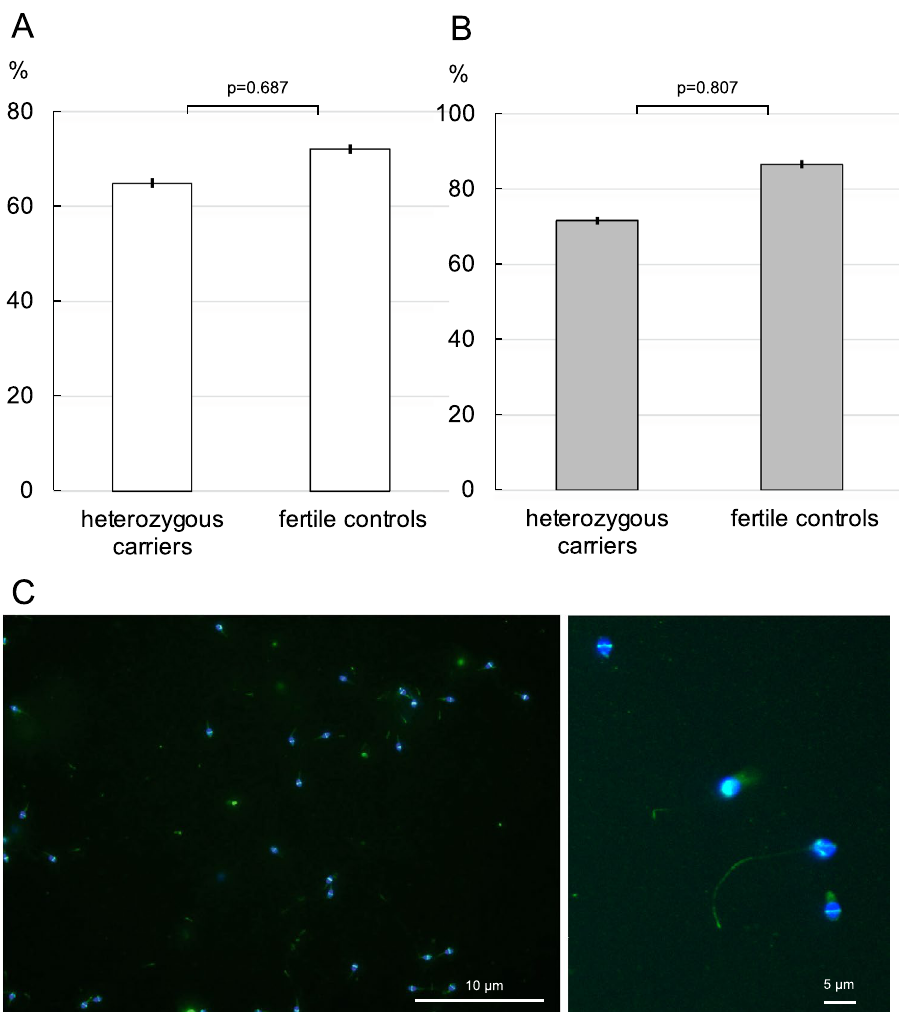
Figure 4. Immunofluorescent staining of the CFTR membrane channel in three heterozygous carriers of the Phe508del-pathogenic variant of the CFTR-gene and three healthy controls demonstrated by similar percentages of spermatozoa with the CFTR protein in the membrane, both in seminal sperm ( A ) and in spermatozoa after swim-up or density gradient centrifugation ( B ). Representative images of spermatozoa stained with the fluorescent anti-CFTR antibody and with the Hoechst 33342-dye ( C